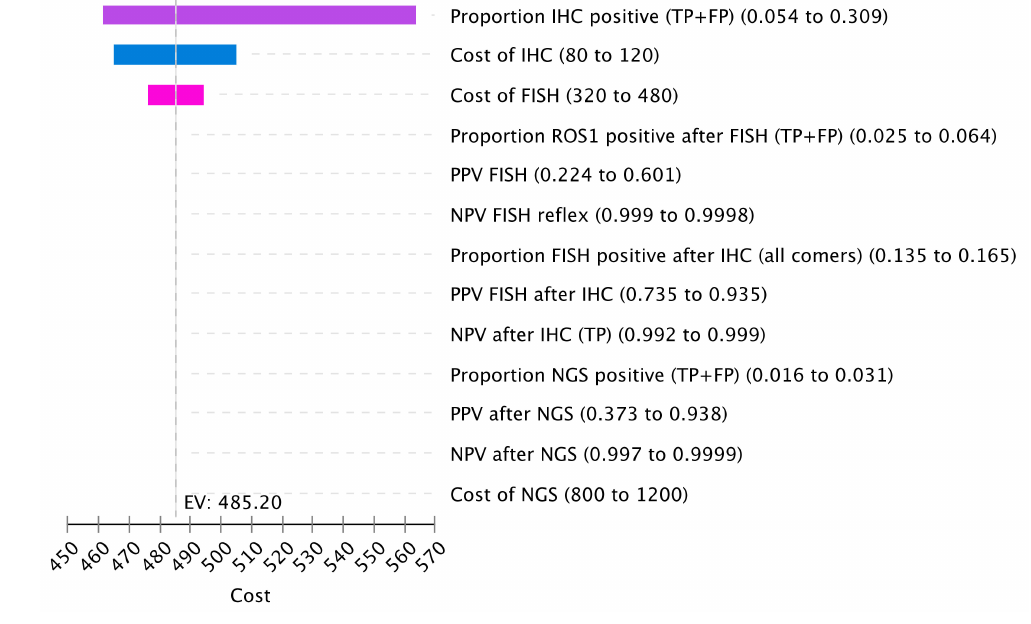
Figure 4. Sensitivity Analysis of Cost Drivers. The tornado diagram represents the one-way sensitiv- ity analysis for cost. Select variables for cost were included for this plot. Input parameters are on the right with the listed variation. Variable definitions are listed in Table